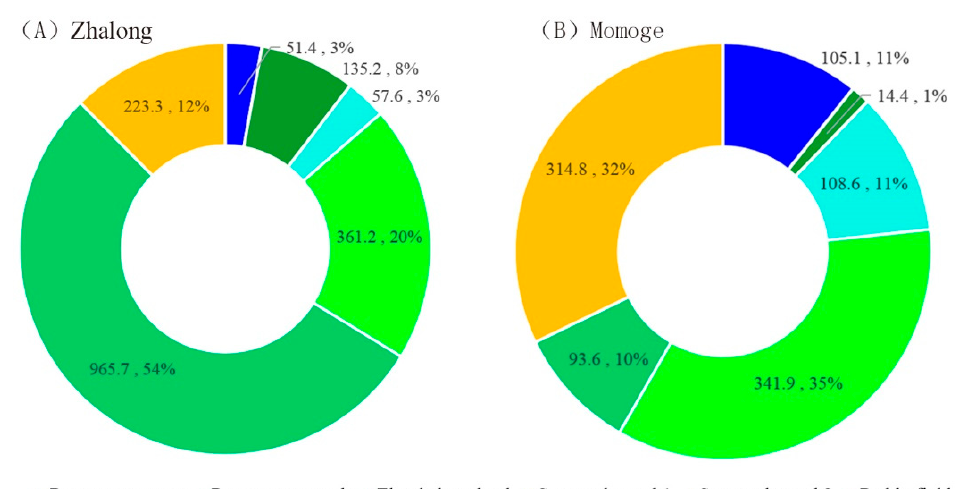
Figure 10. Areal ratio of each wetland type in Zhalong National Nature Reserve and Momoge National Nature Reserve.